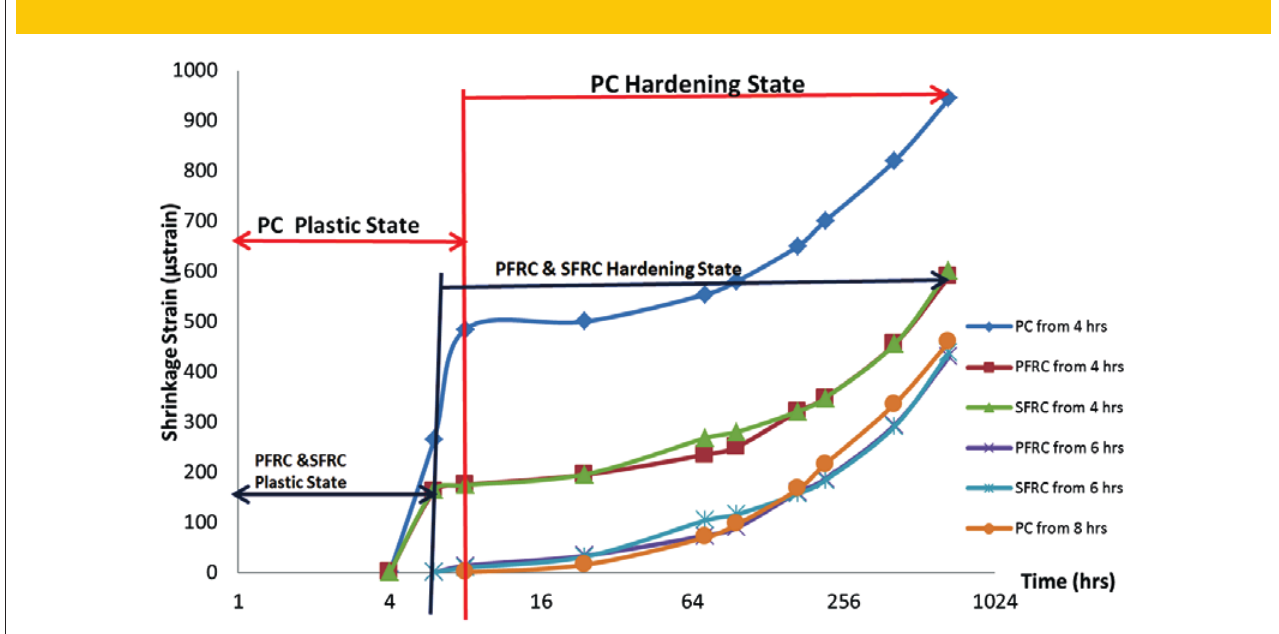
Figure 3 – Shrinkage strain versus time with de dominium of plastic and